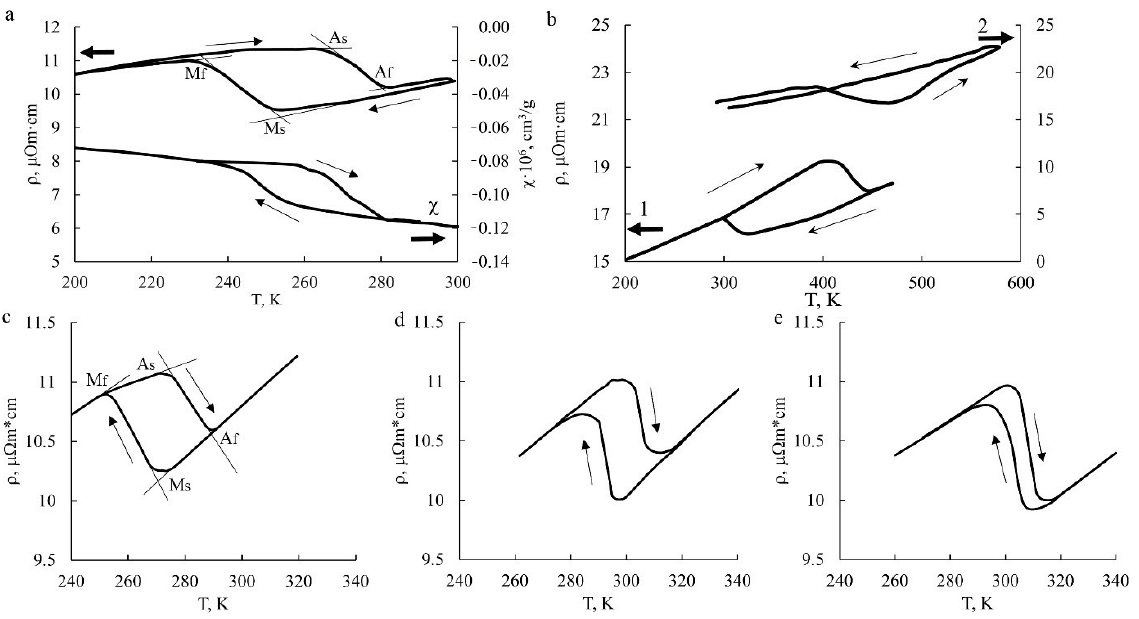
Figure 17. ( a ) Temperature dependences ρ (T) and χ (T) of the Cu–14Al–3Ni alloy after quenching from 1223 K into water upon thermal cycling: cooling from RT to 90 K—heating to RT. ( b ) Temperature dependences of ρ (T) of the Cu-14Al-3Ni alloy after HPT in the measurement cycles 300 K → LN → 470 K → 300 K (curve 1) and 300 K → 573 K → 300 K (curve 2) (LN is an abbr. for liquid nitrogen). ( c – e ) Temperature dependences ρ (T) of the Cu-14Al-4Ni alloy after ( c ) quenching, ( d ) MPC at 973 K, and ( e ) MPC at 773 K. The thin arrows show the cycles of heating and cooling during the experiment [62].